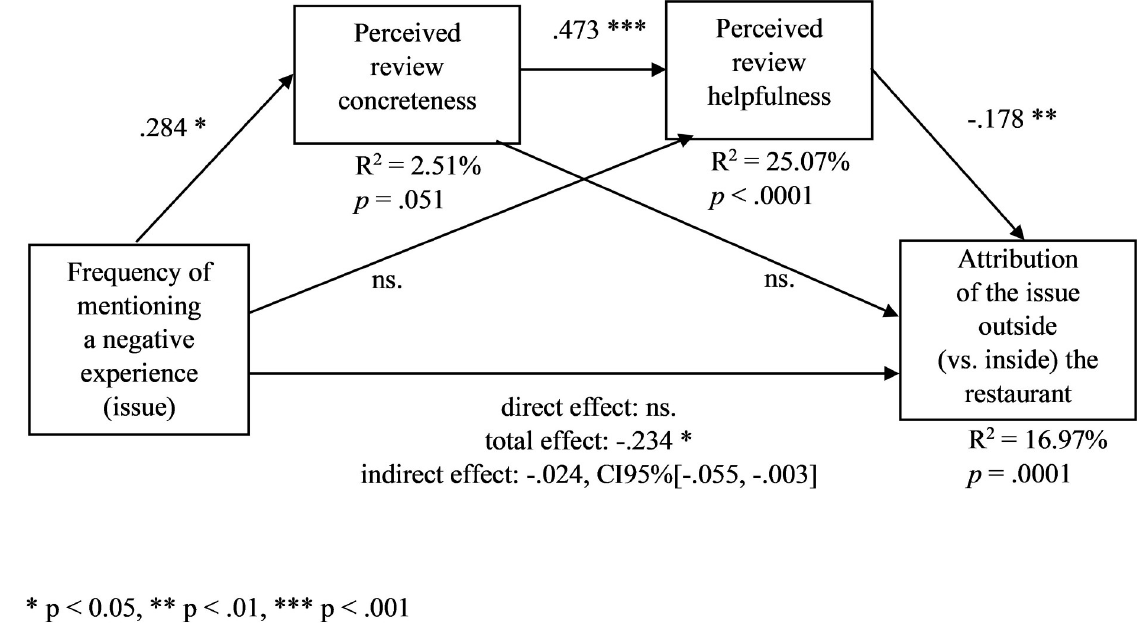
Fig 6. Frequency of mentioning a negative experience (issue) (manipulated), the perceived review concreteness and helpfulness, and the attribution of the issue outside (vs. inside) the restaurant–a serial mediation model (Study 2). The other manipulated variables are included as covariates. � p < 0.05, �� p < .01, ��� p < .001.